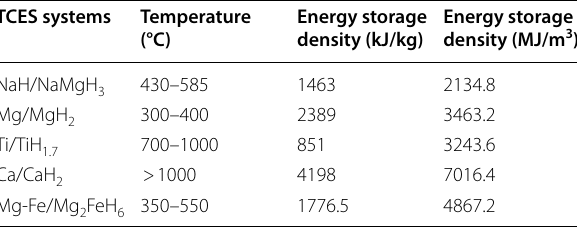
Table 9 Metal hydrides candidates for TCES [164] TCES